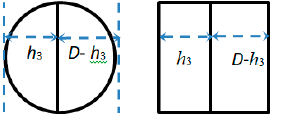
Figure 5. Extreme 3: different material thicknesses.